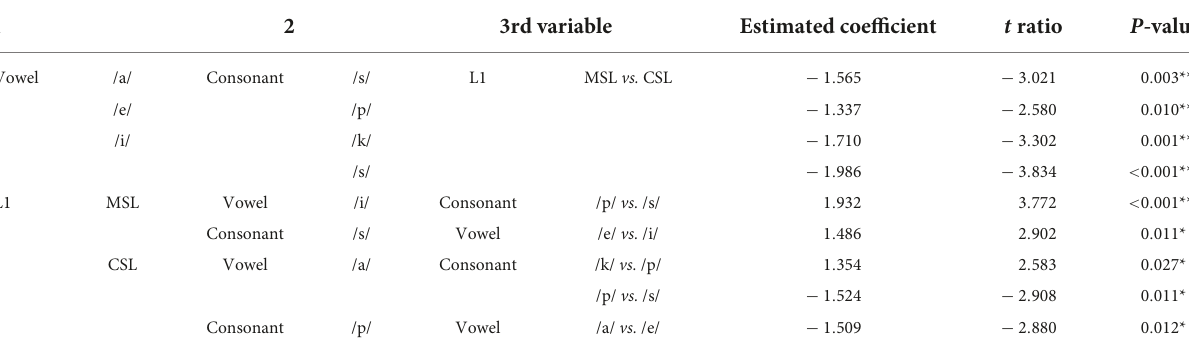
TABLE 4 The three-way interaction (L1 × vowel × consonant) summary: The significant results in pairwise combination. Fixed